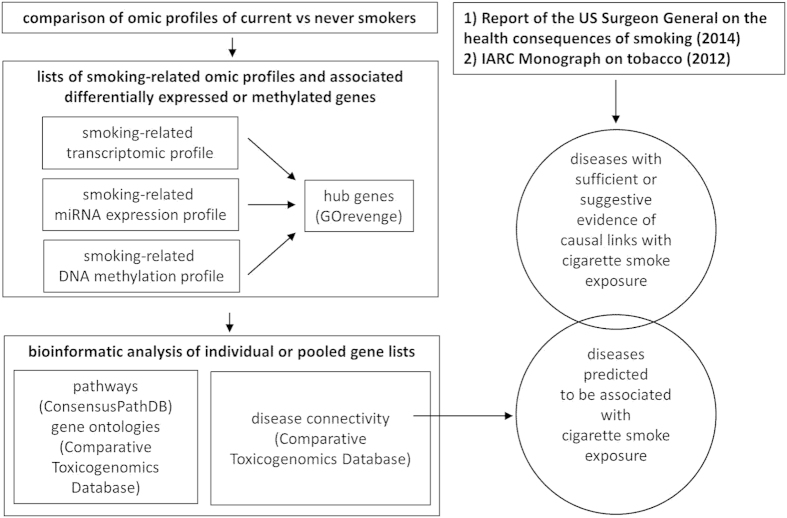
Flow of data and bioinformatics analyses.Further information on the bioinformatics tools employed is given in Methods.